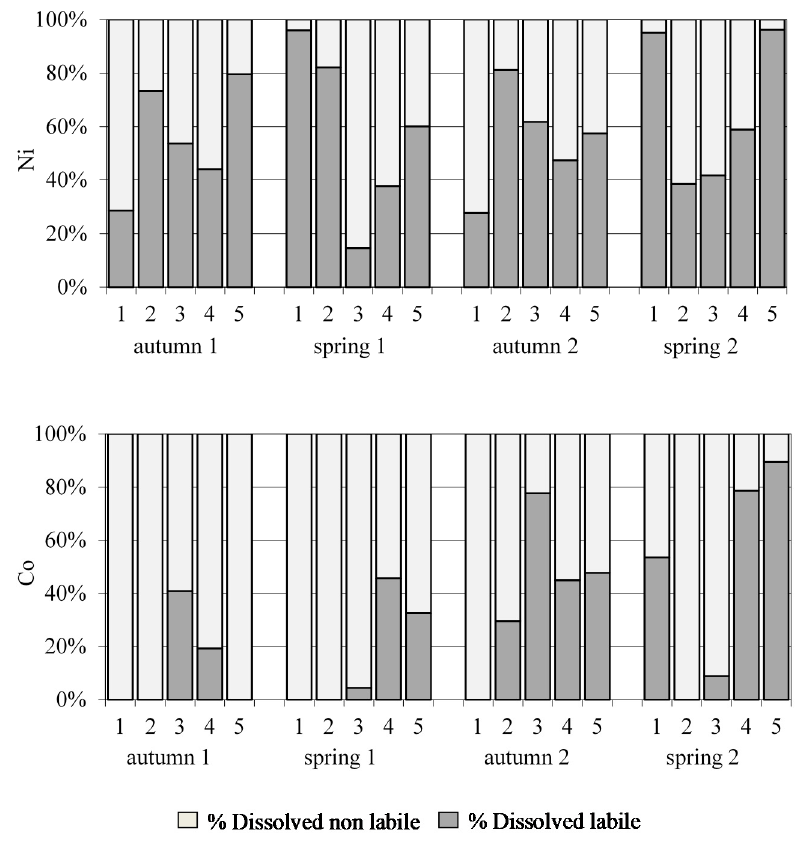
Figure 8. Distribution of dissolved labile and non-labile Ni and Co in water samples of Algeciras Bay.